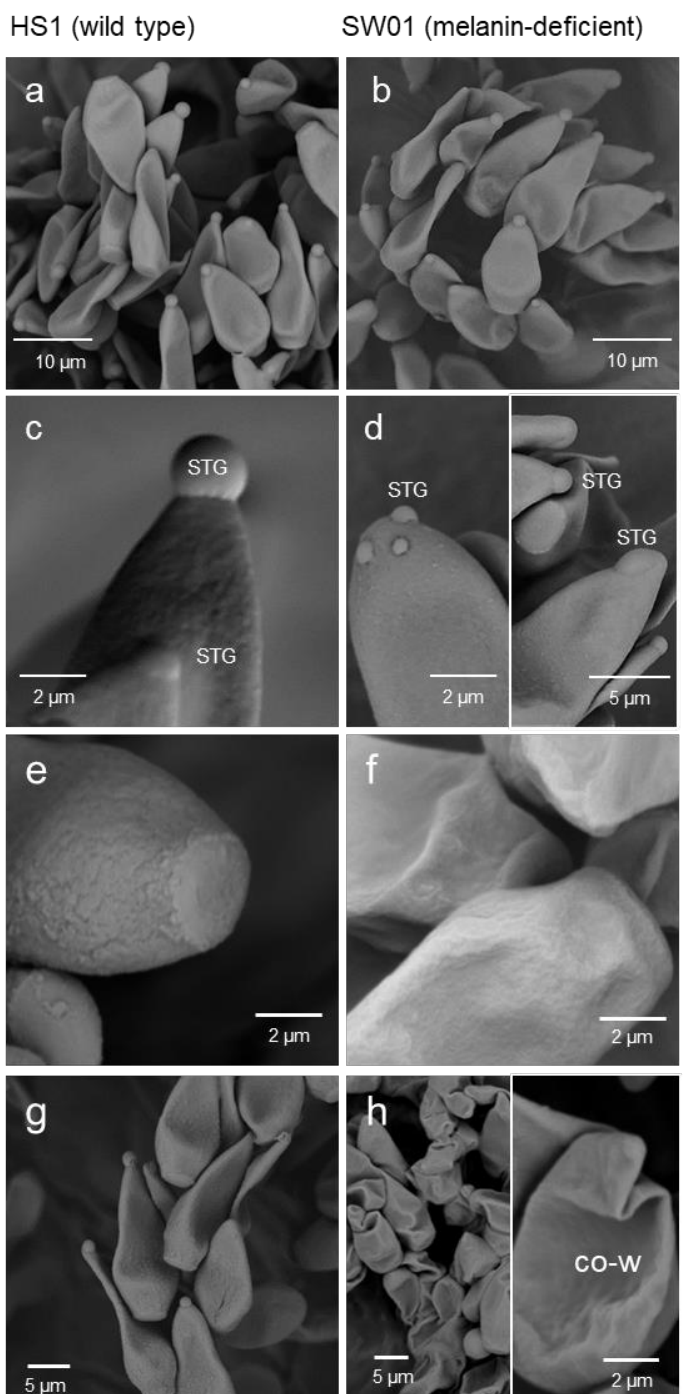
Figure 2. Scanning electron microscopic images of conidia of Venturia inaequalis isolates HS1 (wild-type; a, c, e, g ) and SW01 (melanin-deficient, b, d, f, h ). Mature conidia of both isolates showed an apical spore tip glue (STG; a, b ), which was perfectly centred for isolate HS1 ( c ), and often disaggregated into small droplets or dislocated from the apex for SW01 ( d , left, right); the surface of melanised HS1 conidia showed incrustations, the basal part was almost perfectly roundish and rarely shrivelled ( e ), in contrast to SW01 with rather smooth surface and shrivelled conidia base ( f ); differences in the rigidity of the cell wall resulted in straight and strongly wrinkled dry conidia (co-w) of HS1 and SW01, respectively ( g , h ).